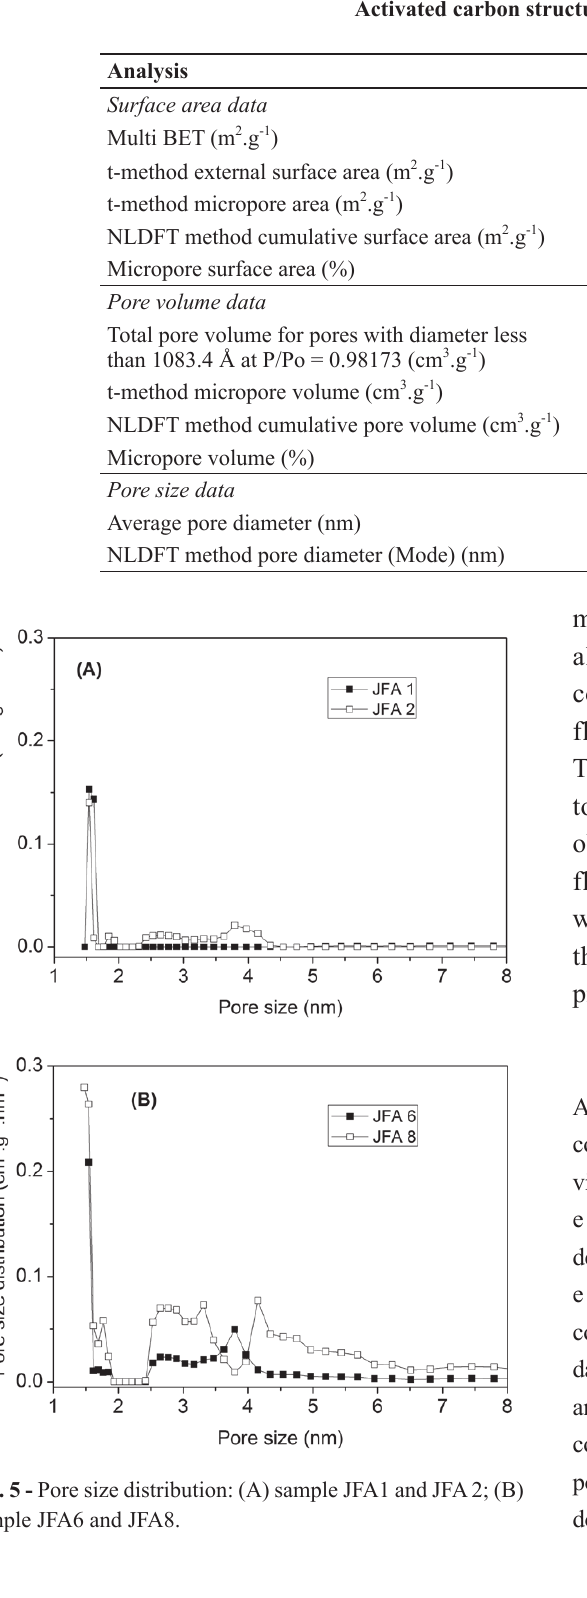
Activated carbon structure related